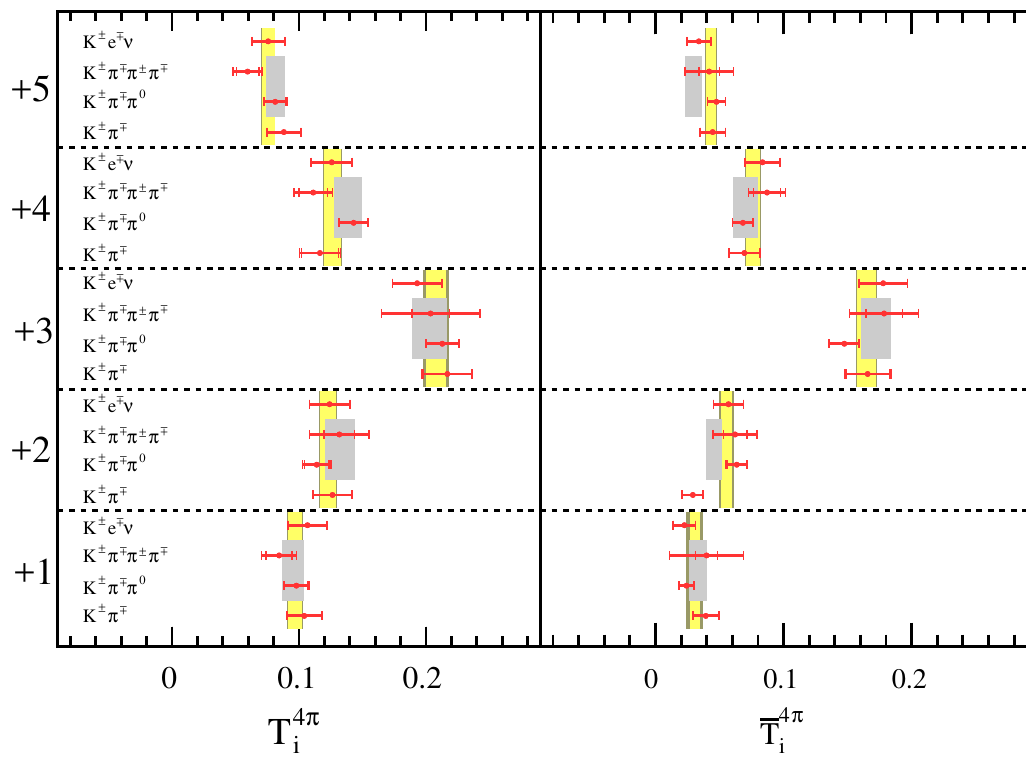
Figure 11 . Constraints on the T 4 (cid:25) and (cid:22) T 4 (cid:25) parameters (fraction of D 0 and D 0 (cid:13)avour tagged i i decays in each bin, repspectively) using the optimal alternative binning scheme with N = 5, deter- mined using di(cid:11)erent subsets of tags. The grey bands show the model predictions and uncertainties. The red lines show the measured values and uncertainties when using a single subset of tags | the inner error bar shows the statistical uncertainty, and the outer error bar shows the combined statistical and systematic uncertainty. The yellow band shows the combined result using all subsets of tags | the lighter shade of yellow represents the statistical uncertainty, and the darker shade of yellow shows the combined statistical and systematic